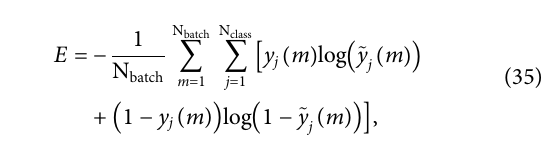
FIGURE 6 | The additional non linearity added by the hierarchical reservoir structure is responsible for a relevant modi fi cation and increase of the performance surface. (A,C) : Auto-correlation structure of the MNIST dataset for two examples of digits, where each pixel is presented one after the other (C) , and auto-correlation structureofthedataaftertherandompermutation (A) .Theoscillatorytrendin C re fl ectstheformofthewrittendigits,whenthisisseenonepixelaftertheother.Theauto- correlation function of the permuted data is low, but not negligible, for all the temporal steps, showing the necessity to have a wide repertoire of timescales in the interval corresponding to the image size. (B,D) : Accuracy of a single ESN for various α values compared the maximum accuracy of the hierarchical ESNs with 4 hidden states (B) or28hiddenstates (D) . (E – F) :casewithlowsamplingfrequencyoftheESNswhichcorrespondstoahigherdemandofinternalmemoryinthereservoir.While the best region ofaccuracy for theunconnectedreservoirsischaracterised byintermediate values ofthe leakage factors, thehierarchically connected network structure reports the best performance when the second network has slower dynamics. (G – H) : The utilisation of a high sampling frequency alleviates the need for long term memory, and the reservoirs prefer the regions with fast timescales. In both cases analyzed, the additional complexity of the hierarchical model leads to a considerable boost in performance. (I – N) : Paths (black line, starting from the circle and ending in the star) that describe the online changes of the leakage terms achieved through the online training algorithm in a zoomed region of the performance surface of α ( 1 ) and α ( 2 ) . The paths are smoothed through a running